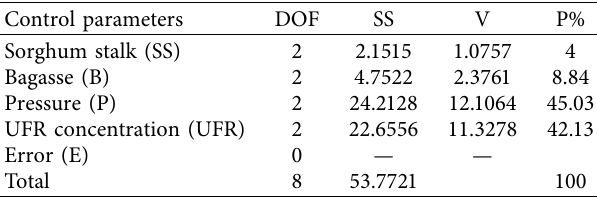
Table 9: Analysis of variance for MOE, using adjusted SS for tests.